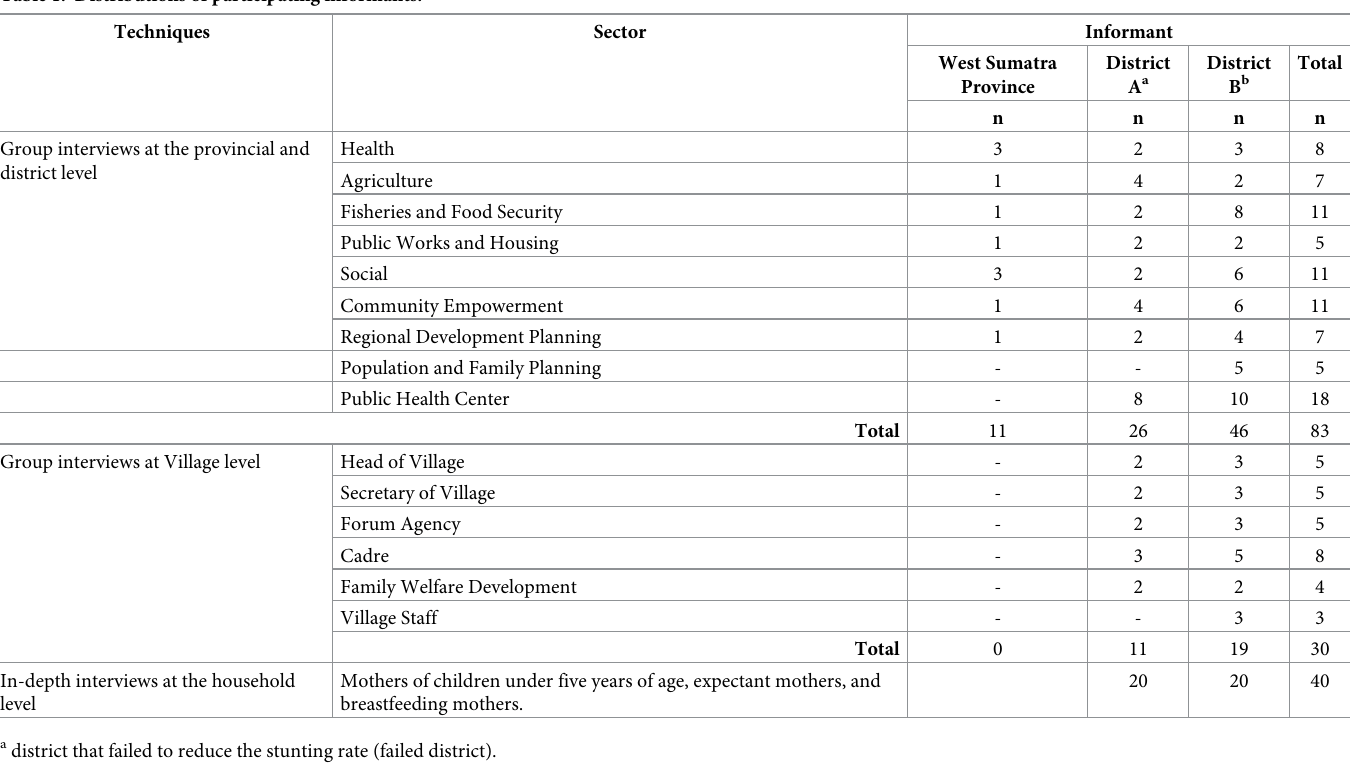
Table 1. Distributions of participating informants. Techniques